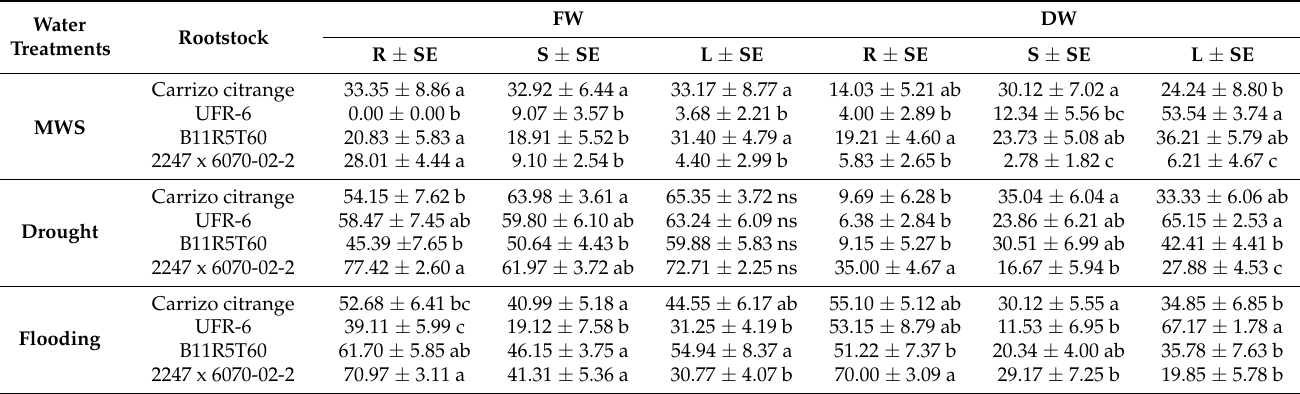
Table 1. Mean percentage of biomass reduction (PBR; %) ± standard error (SE) in roots (R), stems (S), and leaves (L) under fresh weight (FW) and dry weight (DW) conditions, after 30 days of water treatments (MWS, Drought, and Flooding) and with the four citrus rootstocks assayed (Carrizo citrange, UFR-6, B11R5T60, and 2247 x 6070-02-2). Water